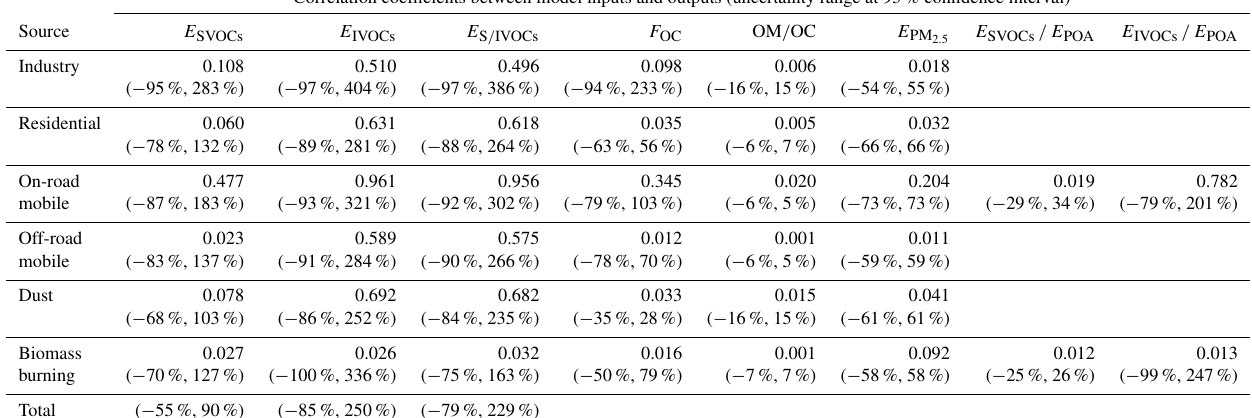
Figure 2. Source-specific emissions in each city for the year 2010. Table 4. Uncertainty assessment of the S–IVOC emission inventory for the year 2010. Correlation coefficients between model inputs and outputs (uncertainty range at 95% confidence